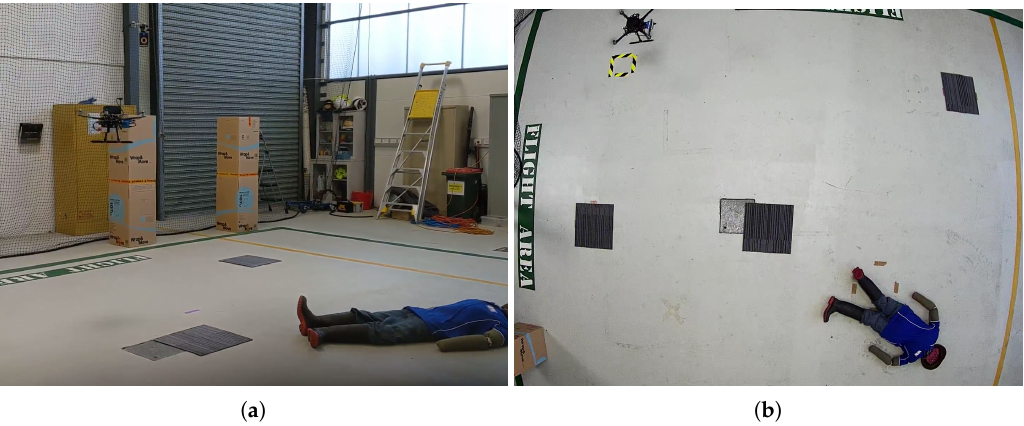
Figure 8. Environment setup for hardware experiments. For safety reasons, an adult mannequin is used as the victim to be detected and column obstacles are replaced with carpet tiles. ( a ) UAV navigating inside a netted area at the Queensland University of Technology (QUT) Da Vinci Precinct (DVP) hangar. ( b ) Top view of the setup with the mannequin displayed at the